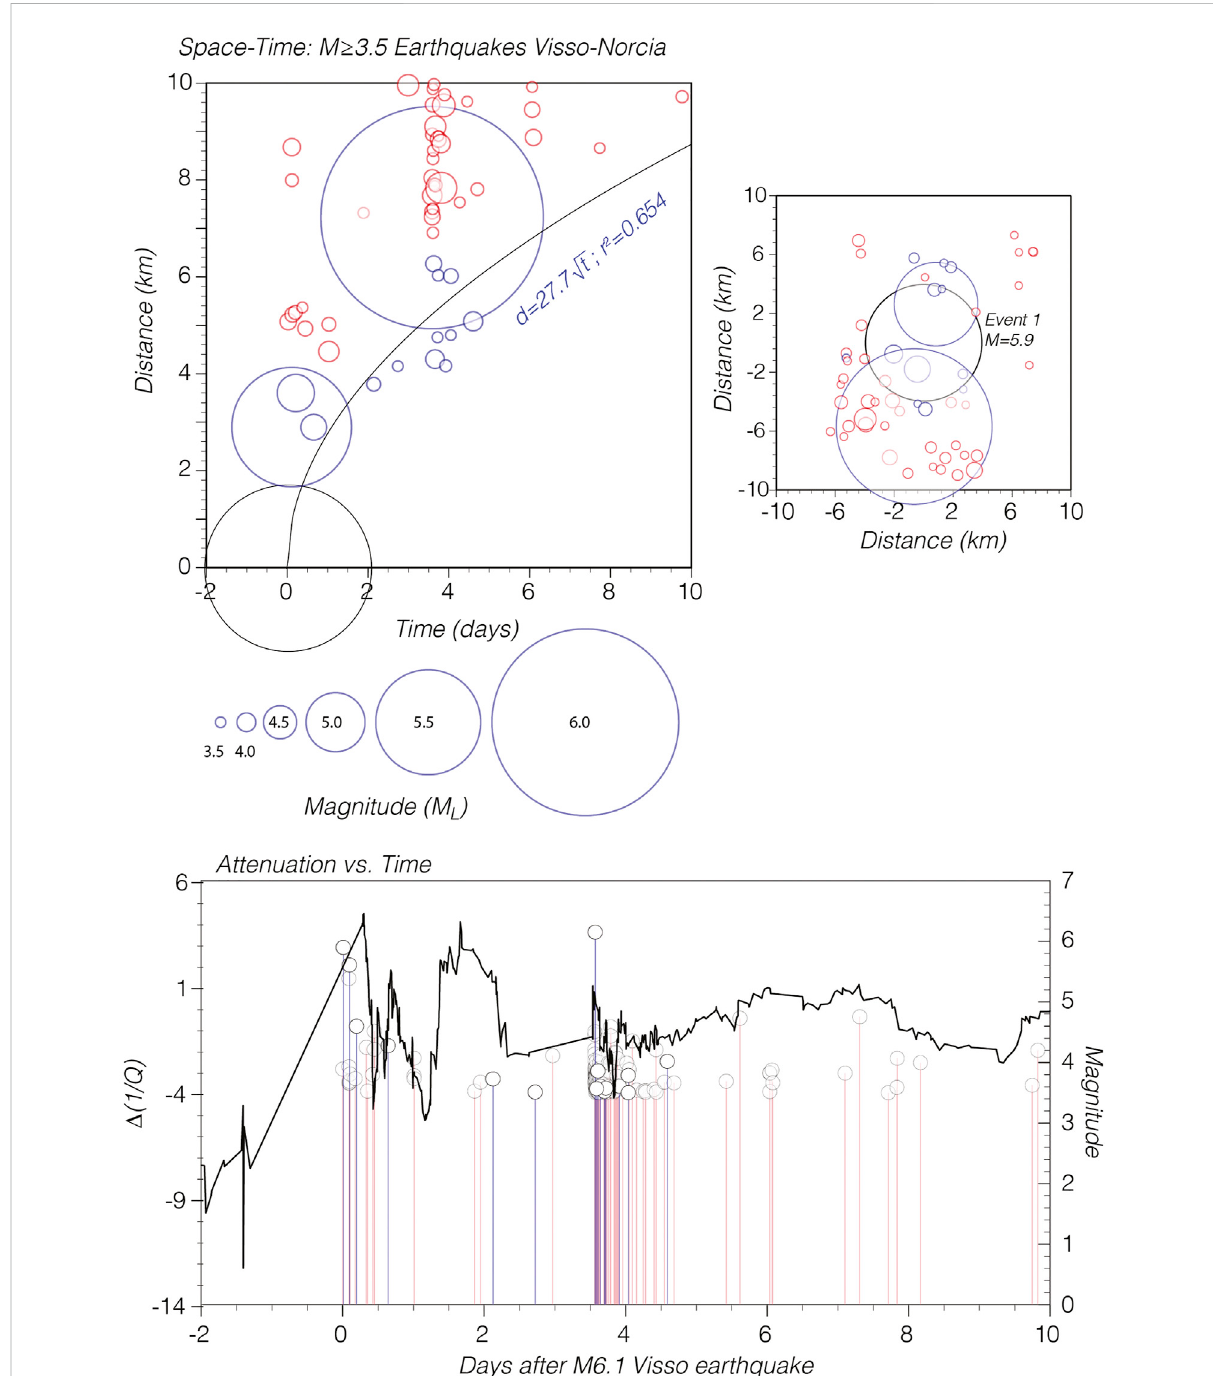
FIGURE 9 Diffusion and attenuation vs.time: Visso-Norcia. Upper :diffusion process associated to themainshocks of Visso (26October 2016) and Norcia (30 October 2016), with a map view to the right. Lower : 2.2 Hz fl uctuation of the seismic attenuation parameter around the pre-Amatrice average. The colors of the vertical lines associated with earthquakes correspond with the earthquakes portrayed by colored circles in the upper